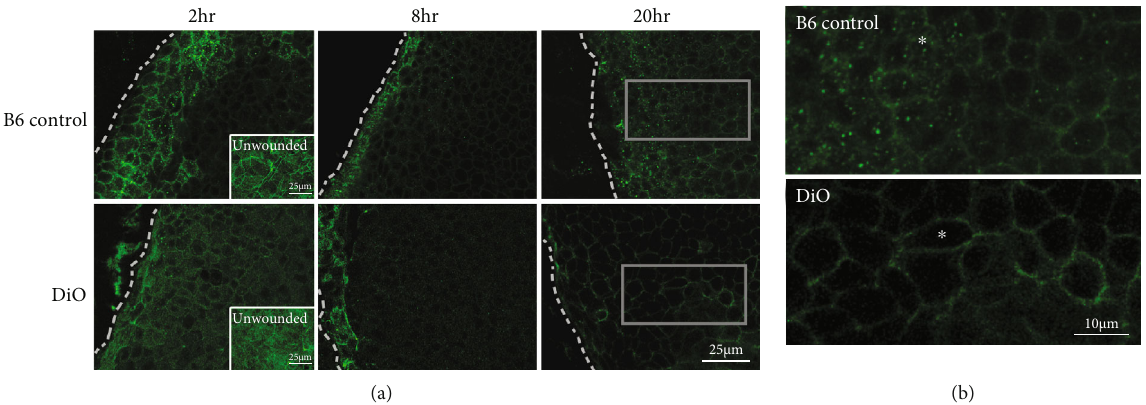
Figure 1: Pannexin1 localization in B6 control and DiO corneal epithelium. (a) Representative confocal immuno fl uorescent images of pannexin1 in unwounded and wounded corneas: 2, 8, and 20hrs postepithelial debridement. Dotted line indicates the leading edge. Bar equals 25 microns. (b) Enlarged immuno fl uorescent images of the rectangular boxes in (a) (20 hrs), which show the cell morphology back from the leading edge. Asterisks ( ∗ ) mark representative cells in both B6 control and DiO ~ 6 cells back from the leading edge. Note the elongation of the ∗ cell in DiO. Bar equals 10 microns. N is a minimum of 3 independent